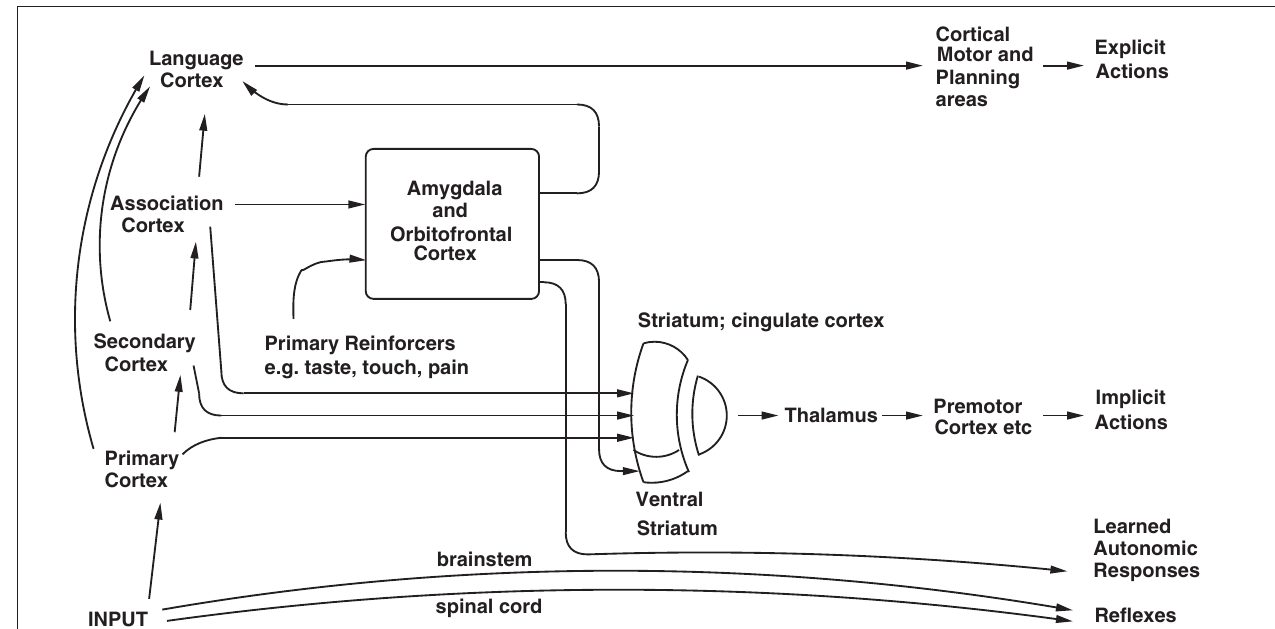
FIGURE 3 | Dual routes to the initiation of action in response to rewarding and punishing stimuli. The inputs from different sensory systems to brain structures such as the orbitofrontal cortex and amygdala allow these brain structures to evaluate the reward- or punishment-related value of incoming stimuli, or of remembered stimuli. The different sensory inputs enable evaluations within the orbitofrontal cortex and amygdala based mainly on the primary (unlearned) reinforcement value for taste, touch and olfactory stimuli, and on the secondary (learned) reinforcement value for visual and auditory stimuli. In the case of vision, the “association